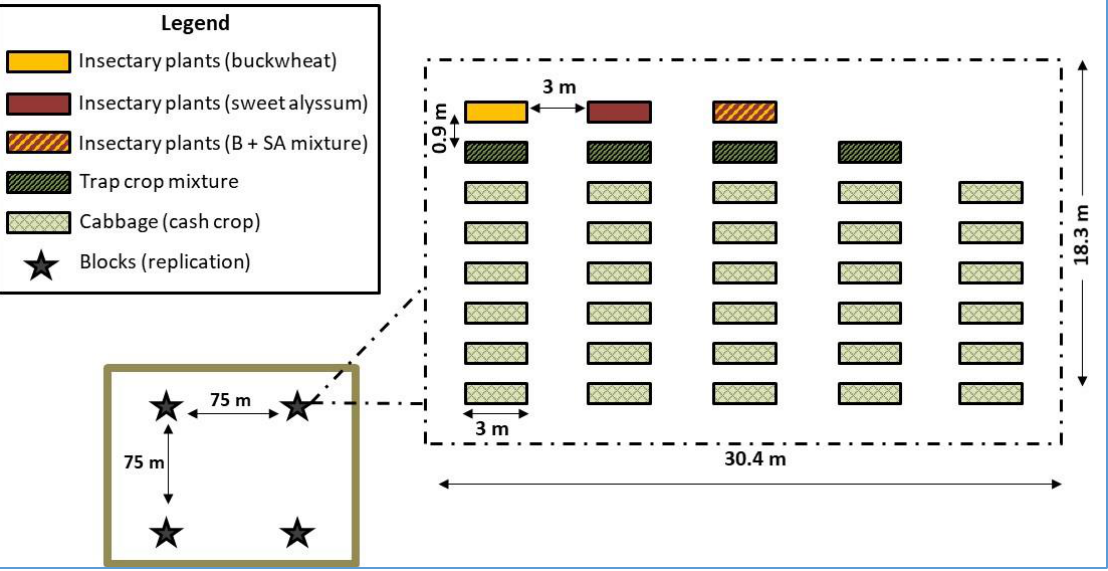
Figure 1. Diagrammatic representation of the field layout for the study conducted at the Lincoln University Alan T. Busby organic research farm. For each plot, the perimeter row was selected for insectary plants (buckwheat alone, sweet alyssum alone, and buckwheat in combination with sweet alyssum = B + SA), the second row was used for trap crop plants, and rows 3-8 were used for the cabbage cash crop.